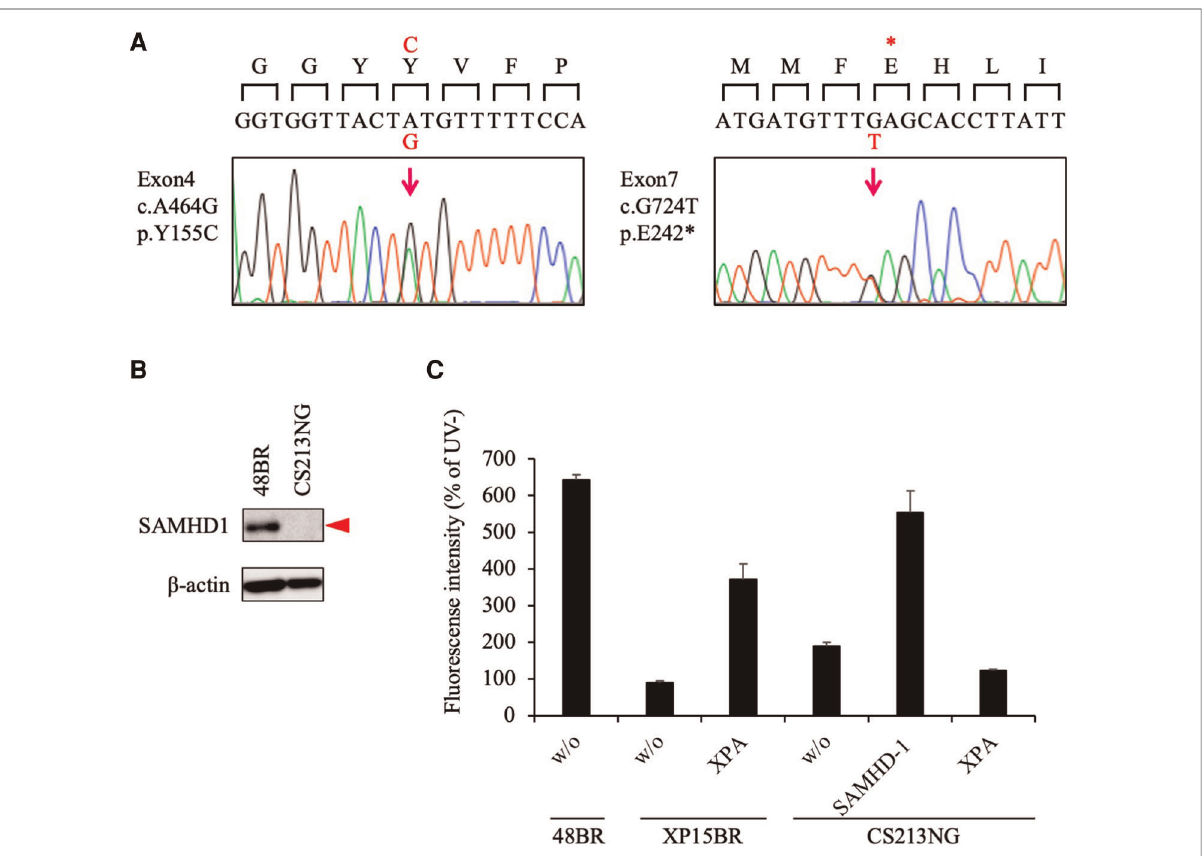
FIGURE 2 Pathogenic variants identi fi ed in the SAMHD1 gene. ( A ) Sanger sequencing con fi rmed that CS213NG is compound heterozygous for the SAMHD1 c.A464G and c.G724T. ( B ) Lack of the SAMHD1 protein expression in CS213NG cells. Bata-actin was a loading control. ( C ) Ectopic expression of the SAMHD1 cDNA complemented the UDS defect of CS213NG cells. CS213NG and XP15BR cells were infected with lentiviruses expressing either of the XPA or SAMHD1 cDNAs (representative data). Error bars represent the standard deviation of four